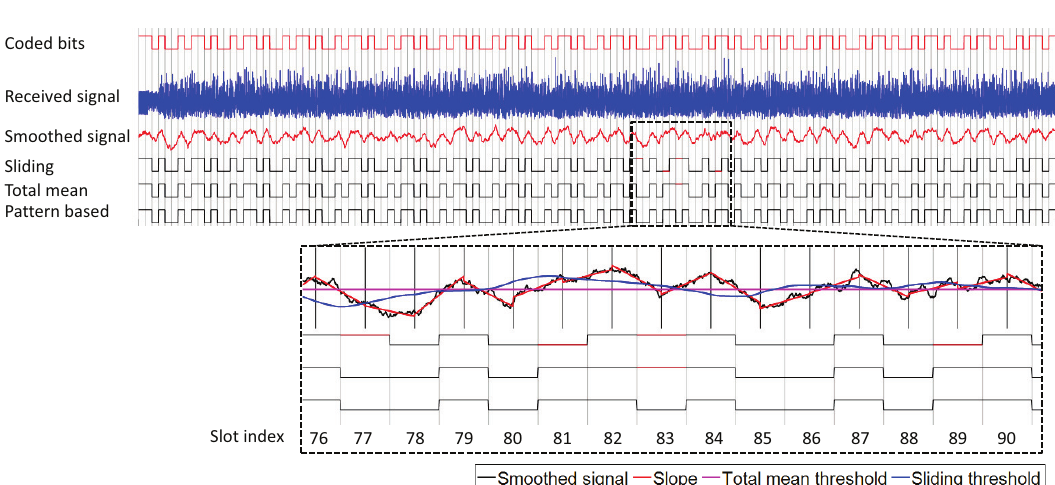
Figure 9. Illustration of the decoding result of different methods for an example Wi-Fi frame with backscattering at a bit rate of 100